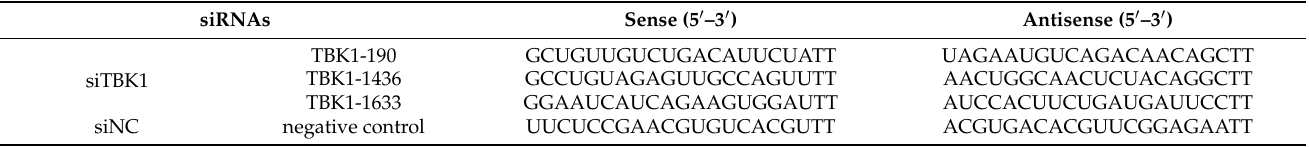
Table 2. List of siRNAs used to knockdown